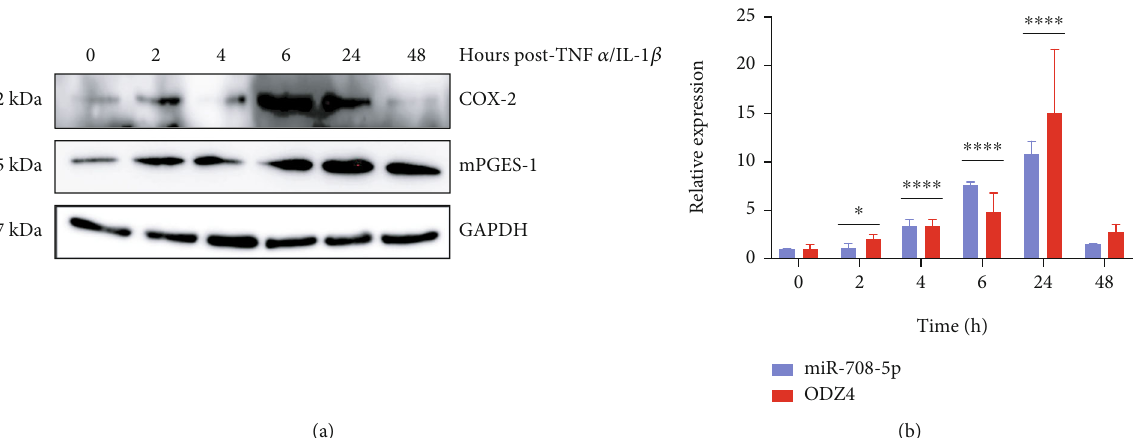
Figure 1: TNF α /IL-1 β modulates COX-2, mPGES-1, and miR-708 expression temporally in nondiseased lung cells. (a) Representative western blot of COX-2 and mPGES-1 protein expression from 0 to 48 hours after TNF α /IL-1 β exposure in Beas2b cells. GAPDH served as a loading control. (b) RT-qPCR of mature miR-708 (blue) and ODZ4 (red) mRNA expression in Beas2b cells 0 – 48 hours post- TNF α /IL-1 β exposure. miR-708 expression was normalized to U6 snRNA while ODZ4 mRNA was normalized to GAPDH mRNA and analyzed using the 2 - ΔΔ CT method. miR-708 and ODZ4 levels were compared to 0 h treatments when determining signi fi cance; ∗ p < 0 : 05 and ∗∗∗∗ p < 0 : 0001 , n ≥ 3 .